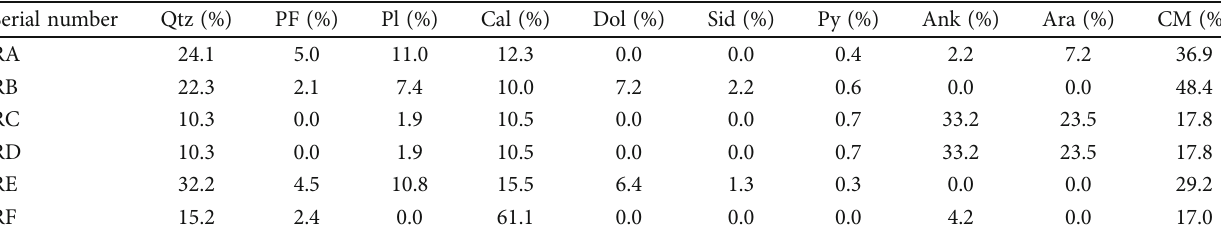
Table 2: Composition characteristics of mudstone and